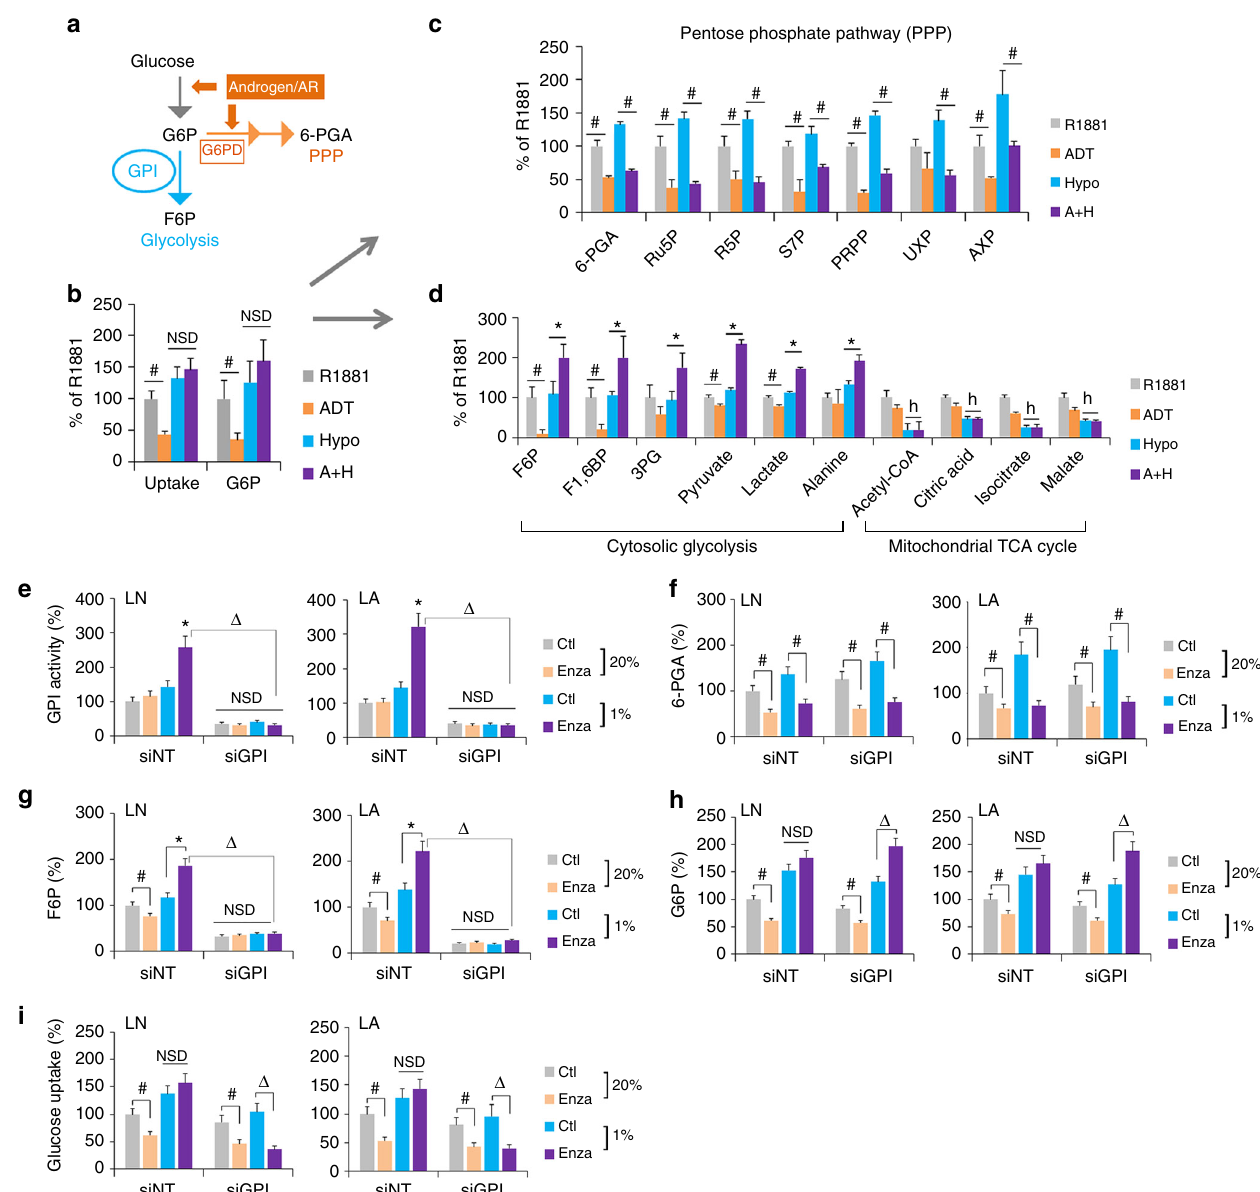
Fig. 5 ADT or enzalutamide in hypoxia rewires glucose metabolism from PPP to glycolysis through GPI. a Schematic representation of glucose